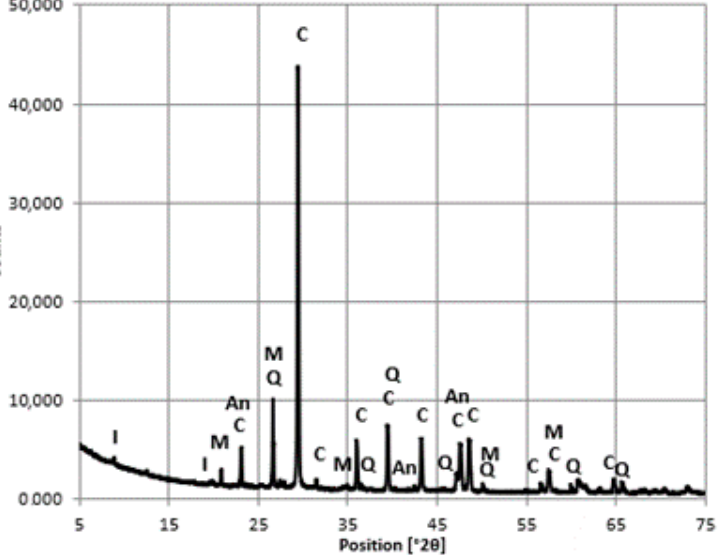
Figure 15. The diffractogram of the aggregate. Designation: I—illite, M—muscovite, Q—quartz, C—calcite, An—anorthoclase.